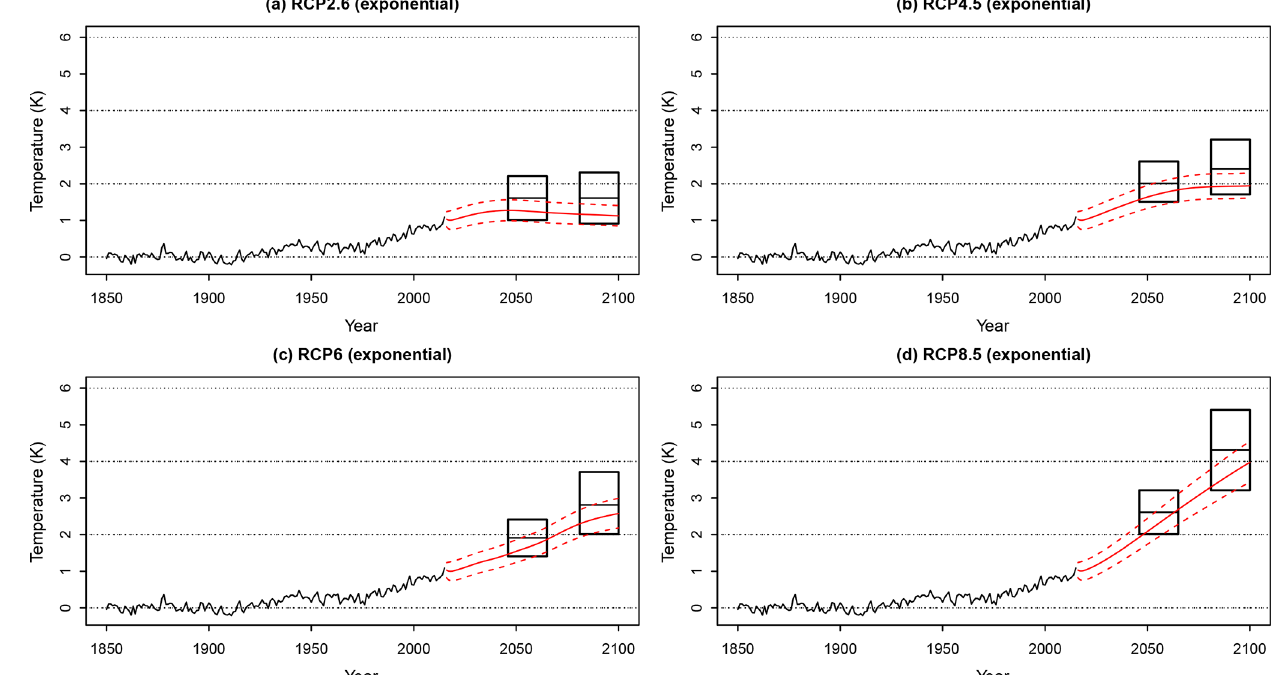
Figure 5. Panels (a) – (d) describe the marginal posterior means and 95% credible intervals of the predicted temperature response to future forcing according to the RCP2.6, RCP4.5, RCP6, and RCP8.5 trajectories, respectively, using a single-exponential response function. These are compared to the AR5 projections (black boxes).